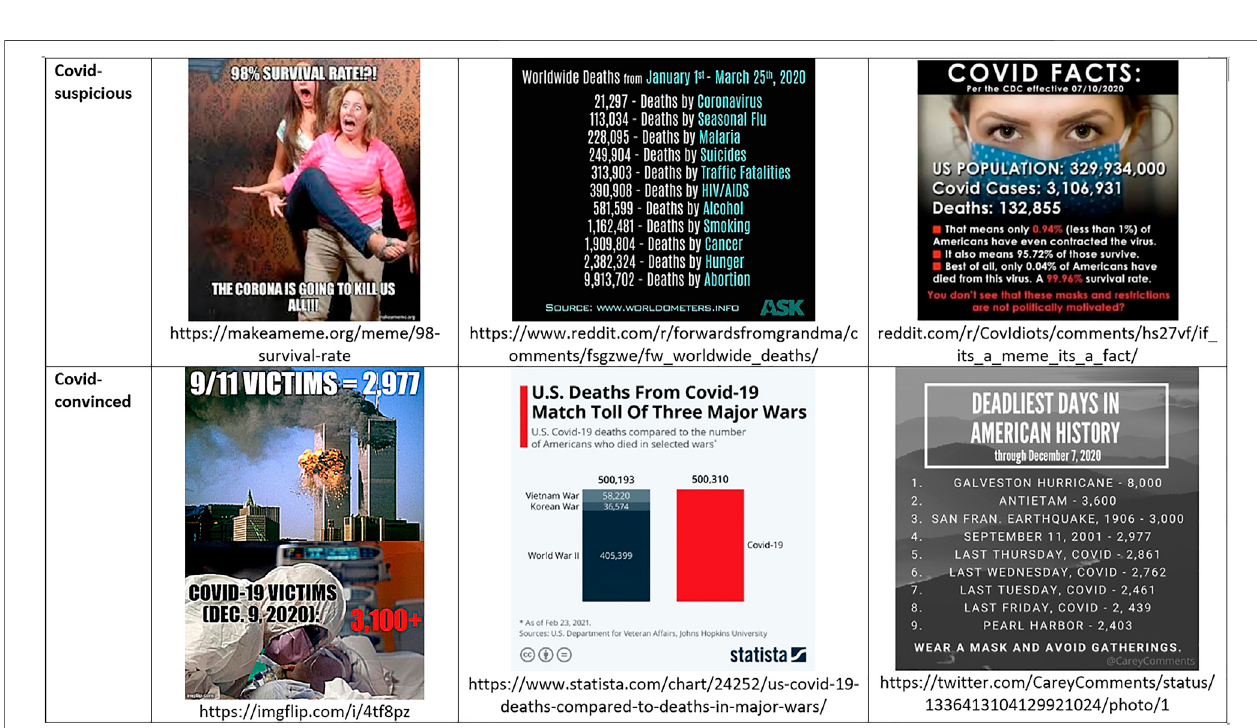
FIGURE 6 | Covid death toll as hinge object connecting Covid-convinced and Covid-suspicious discourses.